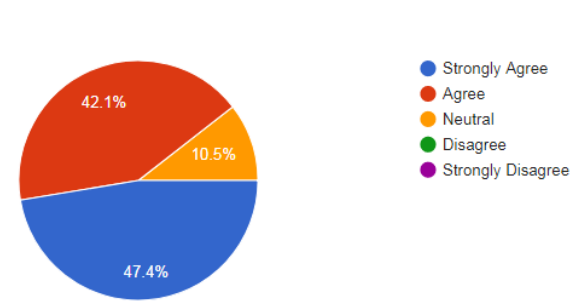
Figure 3: Were the topics covered relevant